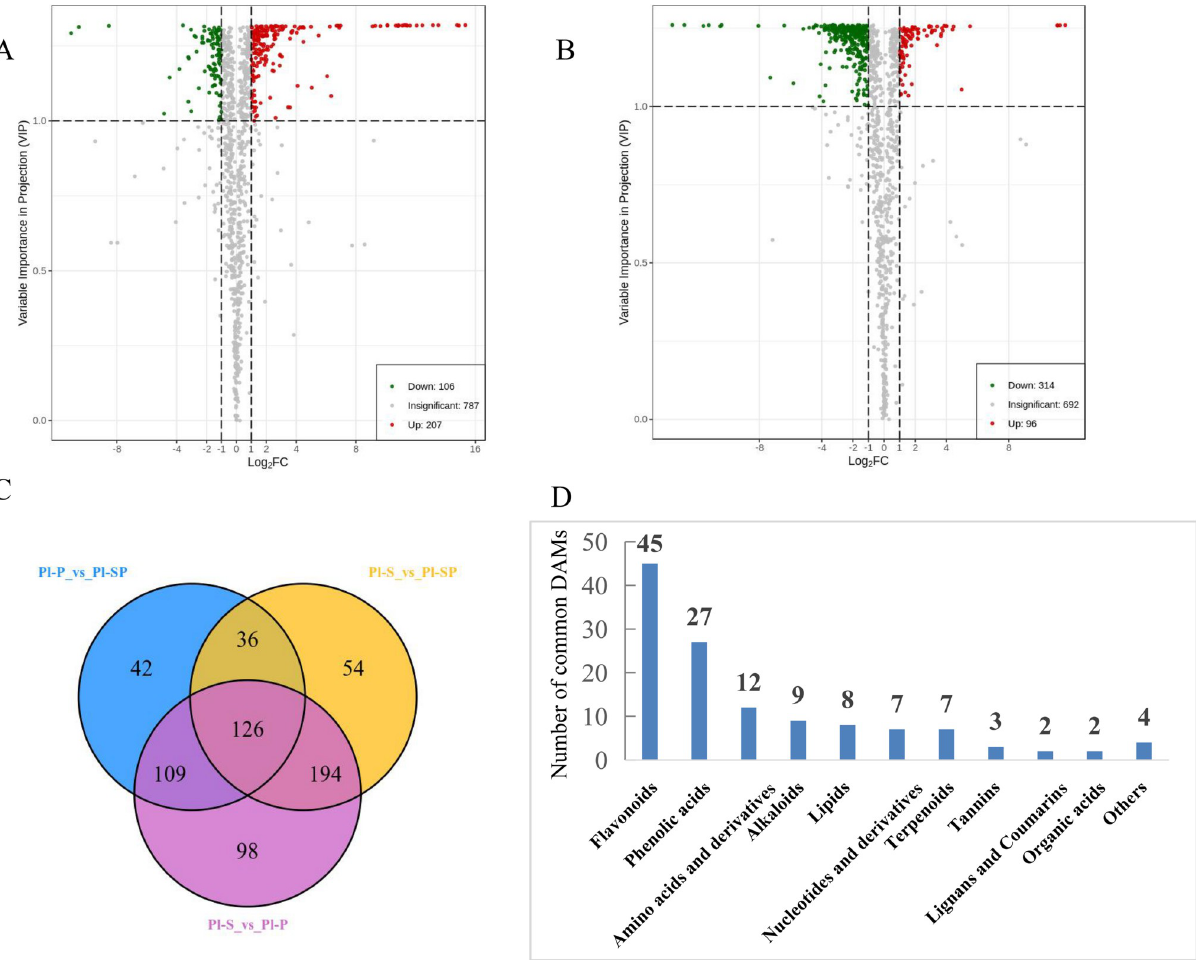
Fig 5. The differential metabolites analysis. A-B. Volcano plot of differential metabolites of the comparison groups Pl-P vs. Pl-SP (A), Pl-S vs. Pl-SP (B). C. The venn diagram of differential metabolites in three comparison groups. D. Number of different types of common differential metabolites.